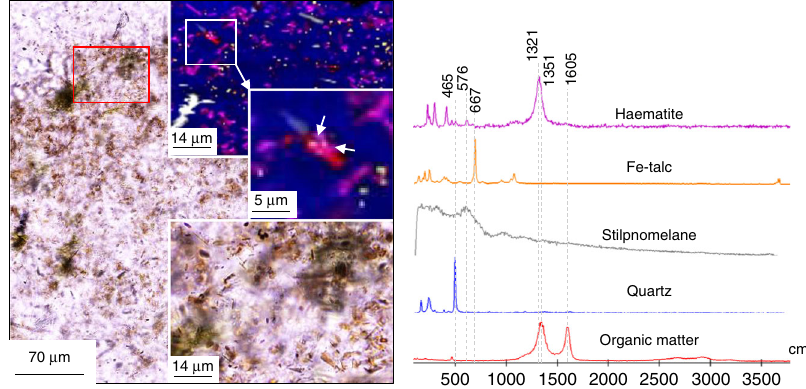
Fig. 6 OM associated with haematite in the Dales gorge BIF. a TL image of haematite layer in the Dales gorge BIF. Bottom right inset is a TL image of the red boxed area. Top right inset is a Raman map of the red boxed area. Middle right inset is a Raman map of the white boxed area. White arrows point to haematite bound with organic matter. b Representative Raman spectra for the this fi